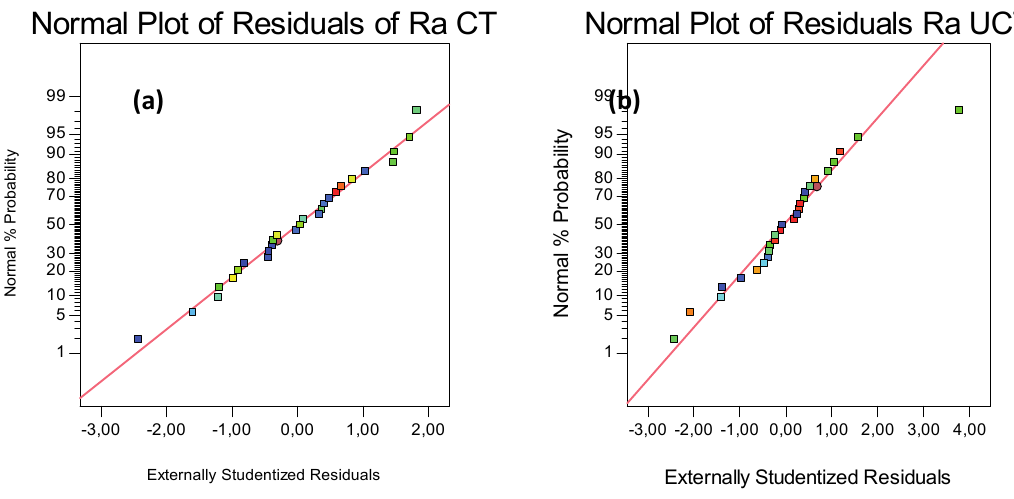
Fig. 4. Normal plot of residuals (a) for coated insert and (b) for uncoated